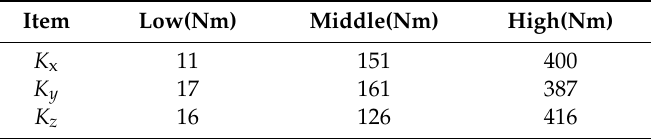
Table 1. Sti ff ness cluster center with K-means ++ . Table 1. Stiffness cluster center with K-means++.